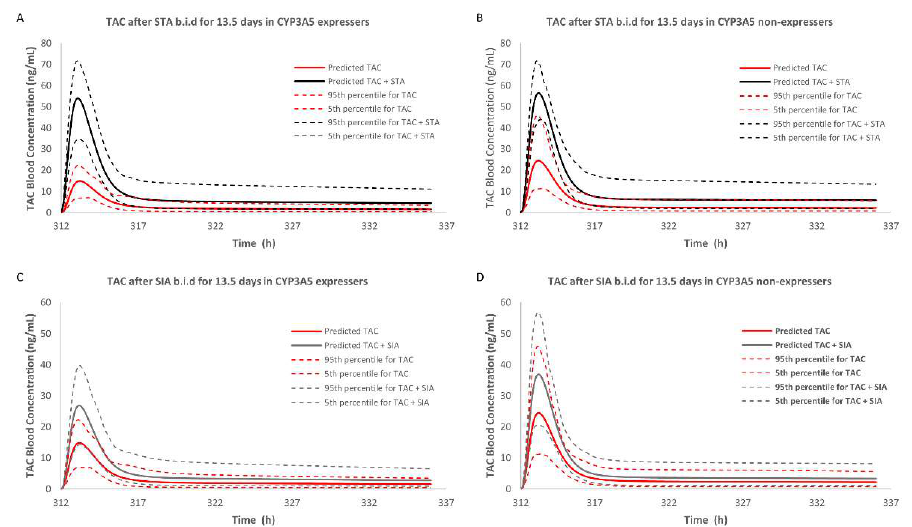
Figure 7. Simulations of blood concentration-time profiles of tacrolimus after multidose of STA (7.325 mg twice daily for 13 days) or SIA (7.2 mg twice daily for 13 days) in CYP3A5 expressers ( A and C ) and CYP3A5 non-expressers ( B and D ) by Simcyp ® .